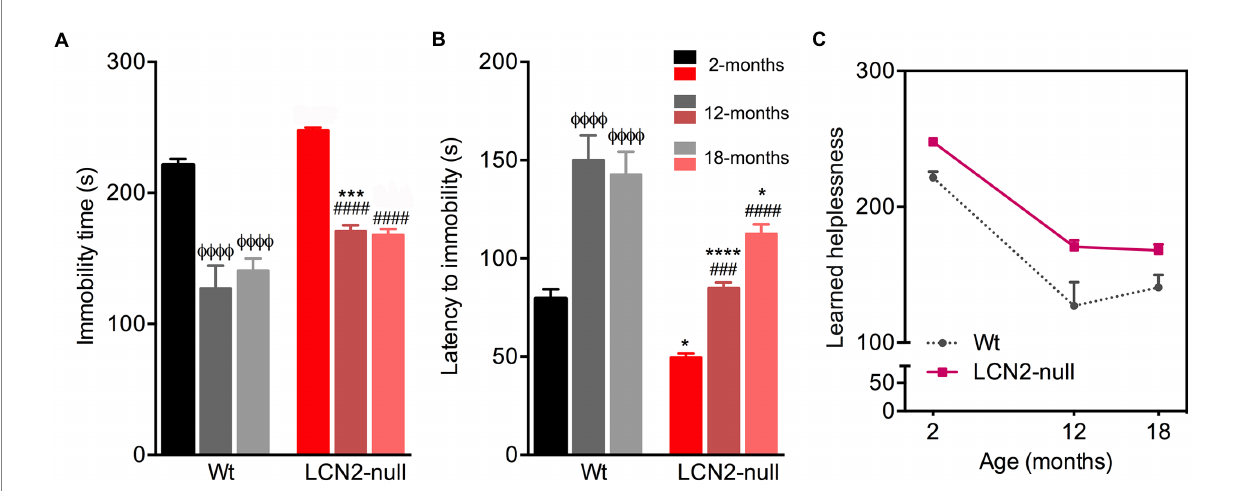
FIGURE 3 Wt and lipocalin-2 (LCN2)-null mice depressive-like behavior in the course of aging. (A) Depressive-like behavior evaluated as learned helplessness in the forced-swim test (FST) revealed decreased immobility time in older Wt and LCN2-null mice, with null aged mice continuing to present a depressive-like behavior ( n = 10–12 mice per group). (B) Mood alterations in older mice were also observed by the latency of time to immobility. (C) Depressive-like behavior in the progress of aging remains in LCN2-null mice, compared to controls, while older Wt animals decreased their immobility time. Data are presented as mean ± SEM, analyzed by two-way ANOVA with Bonferroni’s multiple comparison test. Φ Denotes differences between young and aged Wt mice; # between differences between young and aged LCN2-null mice; *between Wt and LCN2-null mice at each matched age. * p ≤ 0.05, ## p ≤ 0.01, *** p ≤ 0.001, ΦΦΦΦ , ####, **** p ≤